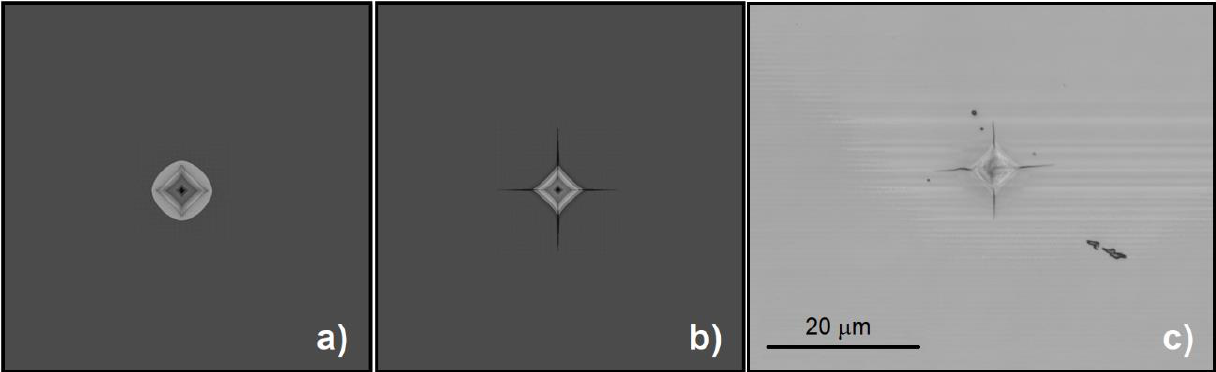
Figure 9. Indentation with the maximal loading force P max = 300 mN: ( a ) state at maximal load (numerical simulation), ( b ) state after complete unloading (numerical simulation), ( c ) state after complete unloading (experimental observation).